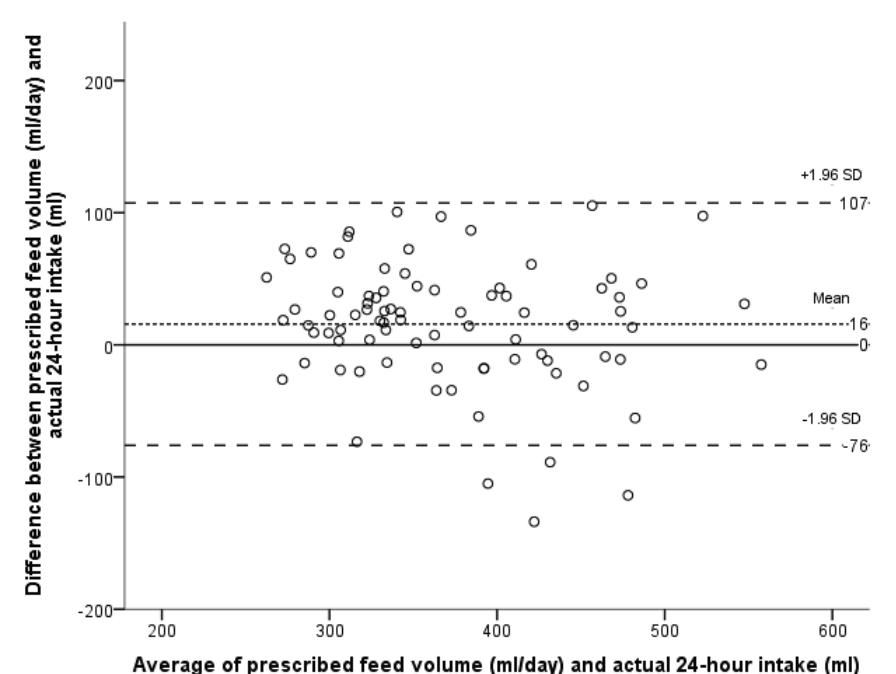
Figure 1. Bland-Altman plot of the agreement between the prescribed feed volume in mL/day and the actual 24-h intake of the infant; each point represents one infant’s intake over 24 h (N = 103).